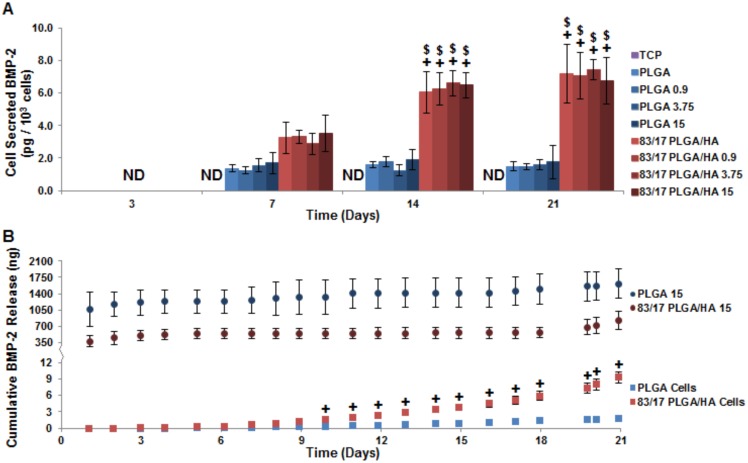
Cell-based BMP-2 production unaltered by loading exogenous BMP-2 on scaffolds.(A) Total BMP-2 as analyzed by ELISA and normalized by cell count. (B) Cumulatively released BMP-2 from protein-loaded scaffolds (top) or MSCs seeded on protein-free scaffolds (bottom). ND =  Not Detectable; N = 4; p<0.05 for * =  TCP (same time point), + =  PLGA (same BMP-2 loading and same time point), > =  PLGA 15 (same time point), ∧ = 83/17 15 (same time point), # =  Same Experimental Group (Day 3), $ =  Same Experimental Group (Day 7), and & =  Same Experimental Group (Day 14).